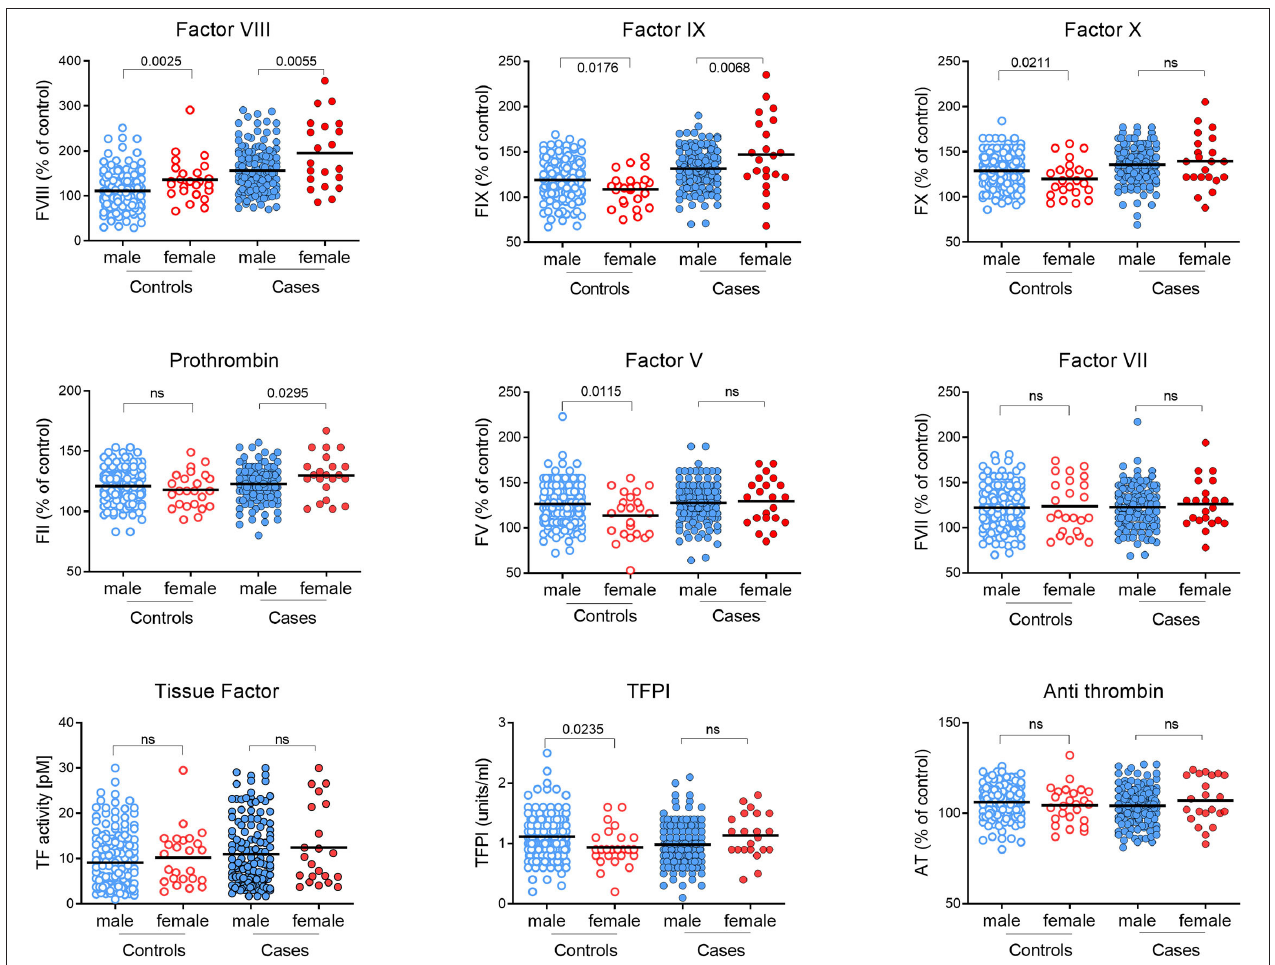
FIGURE 5 | Comparison of coagulation proteins in plasma from male and female MI subjects and controls. Levels of each coagulation factor were measured in plasma from pMI cases and controls analyzed according to gender. Factors II, V, VII, VIII, IX, X, and antithrombin (AT) are reported as the percentage of reference control plasma included in each analysis, and Tissue Factor (TF) and Tissue Factor Pathway Inhibitor (TFPI) are reported as activity (pM) and (U/mL), respectively. ( n = 139 and 23, for male and female cases; and n = 161 and 25 for male and female controls). ( P -values derived by unpaired t-test after confirming data were normally